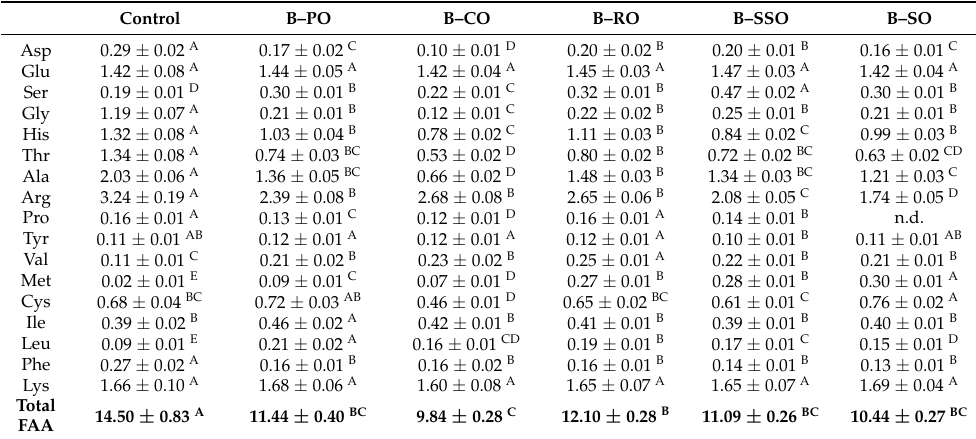
Table 2. Chang of FAAs (ug/g) in fried bacon using different vegetable